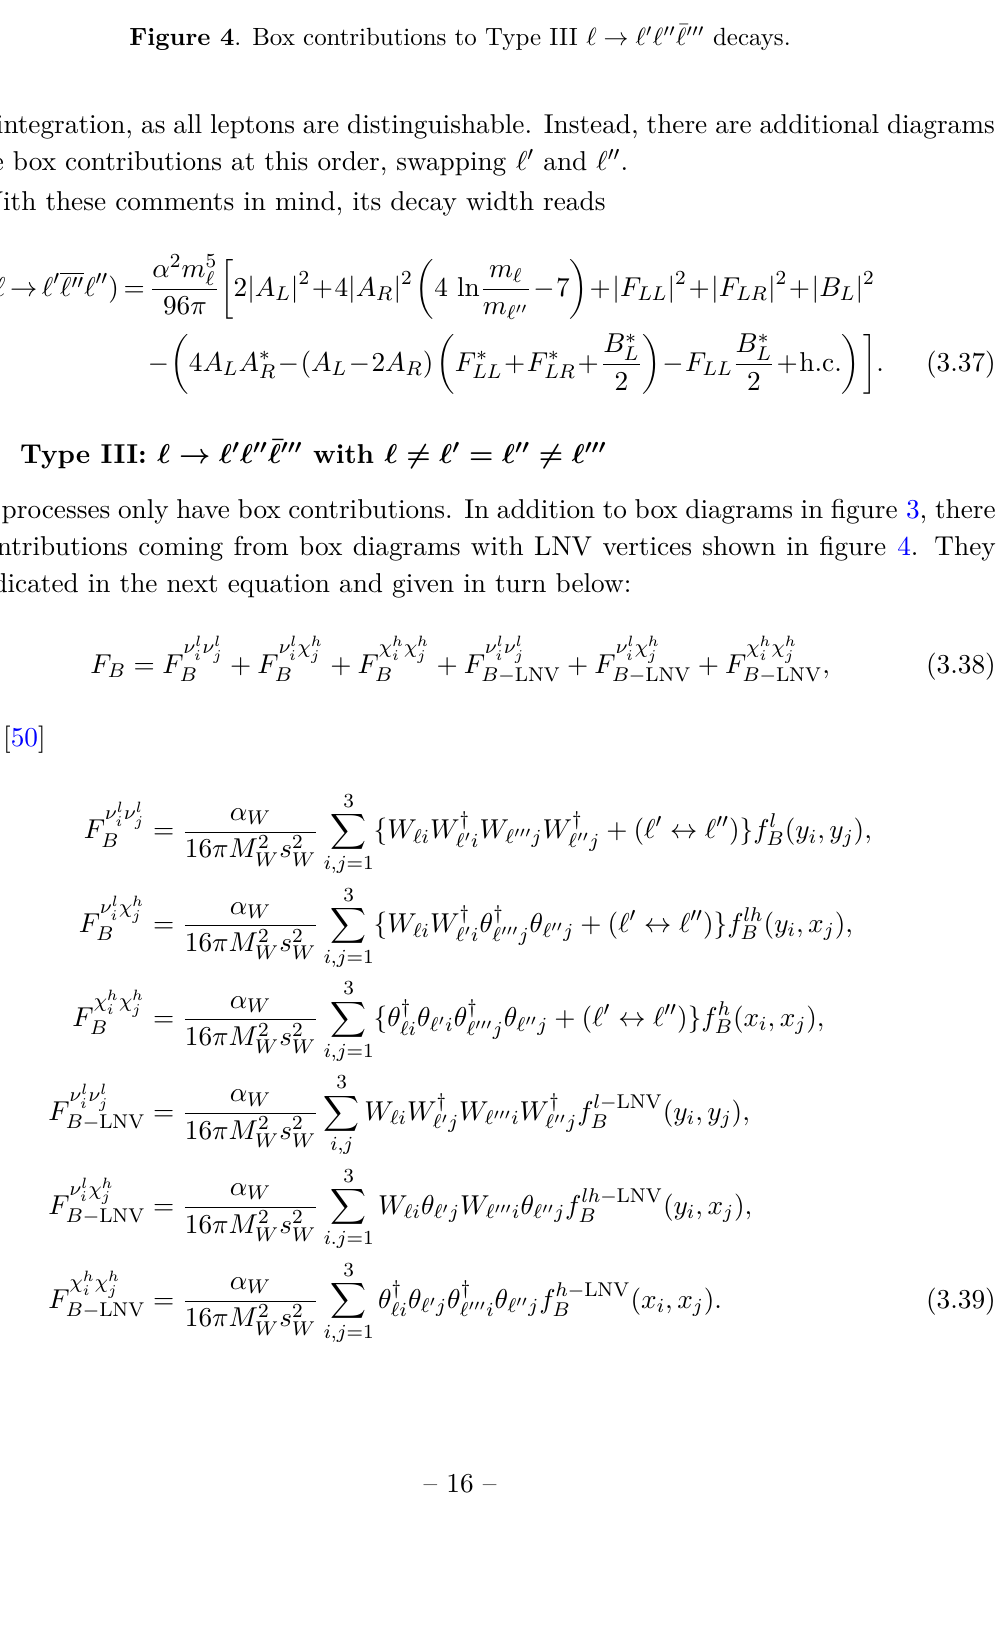
Figure 4 . Box contributions to Type III ‘ → ‘ 0 ‘ 00